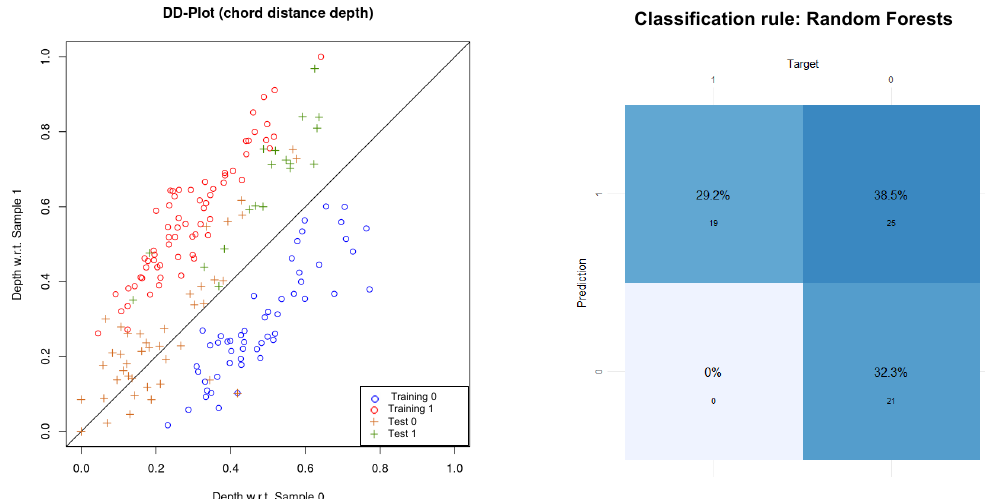
Figure 8. Results of applying the DD G -classifier(ChordDist,RF) to the multivariate text data (no Fourier transform is performed yet). The DD -plot on the left uses the chord distance depth, and random forest as the classification rule. The right plot represents the confusion matrix resulting from applying the former procedure to the test sample. The red and blue points indicate whether the observations in the training sample belong to class 1 or 0, respectively. The green and orange crosses are the test observations corresponding to class 1 and 0,